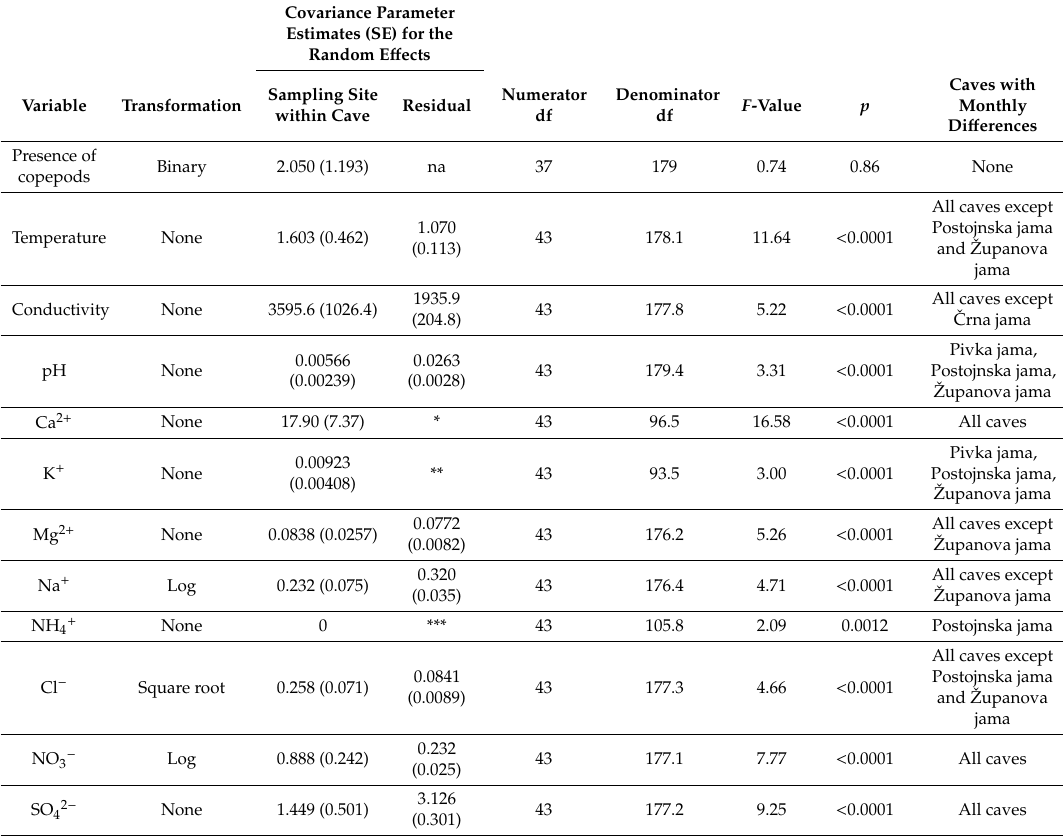
Table 4. General linear mixed model type III tests of fixed e ff ect of month / cave combination on presence / absence of copepods and on the chemical and physical variables. NO 2 − was not included because it was not possible to normalize the variable. The list of caves with monthly di ff erences includes all caves with at least one significant di ff erence among months. Some of the results are graphically displayed in Figure